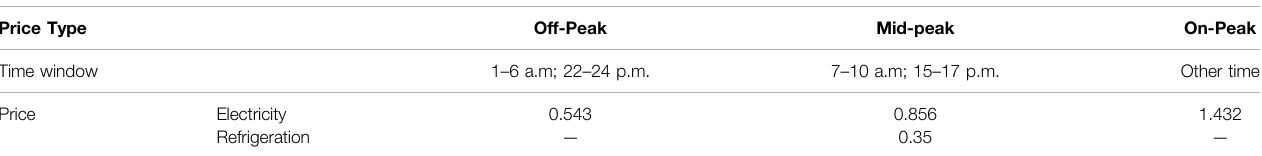
TABLE 4 | UGO wholesale prices on a typical day CNY/kWh.